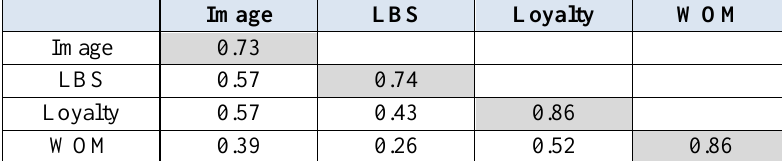
Table 2. Discriminant validity